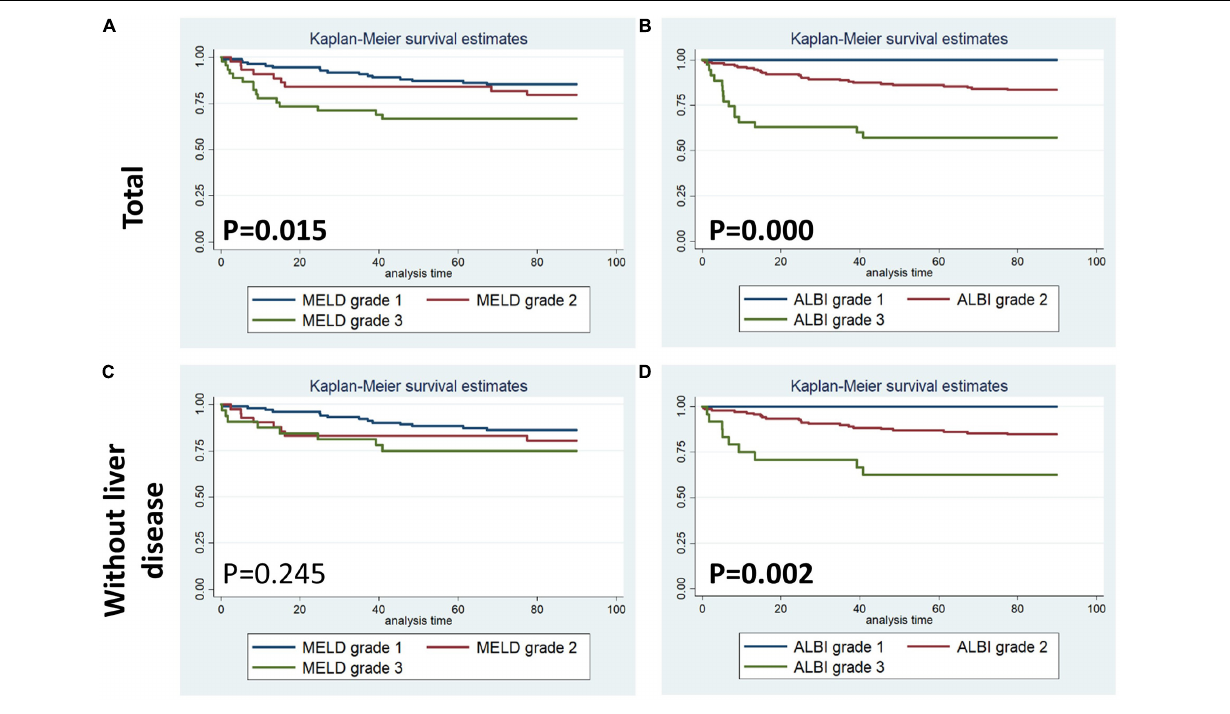
FIGURE 2 | Kaplan–Meier 90-day survival curves comparing patients by liver function score levels (MELD and ALBI score). (A,B) Total patients with PPH. (C,D) Patients with PPH and without liver